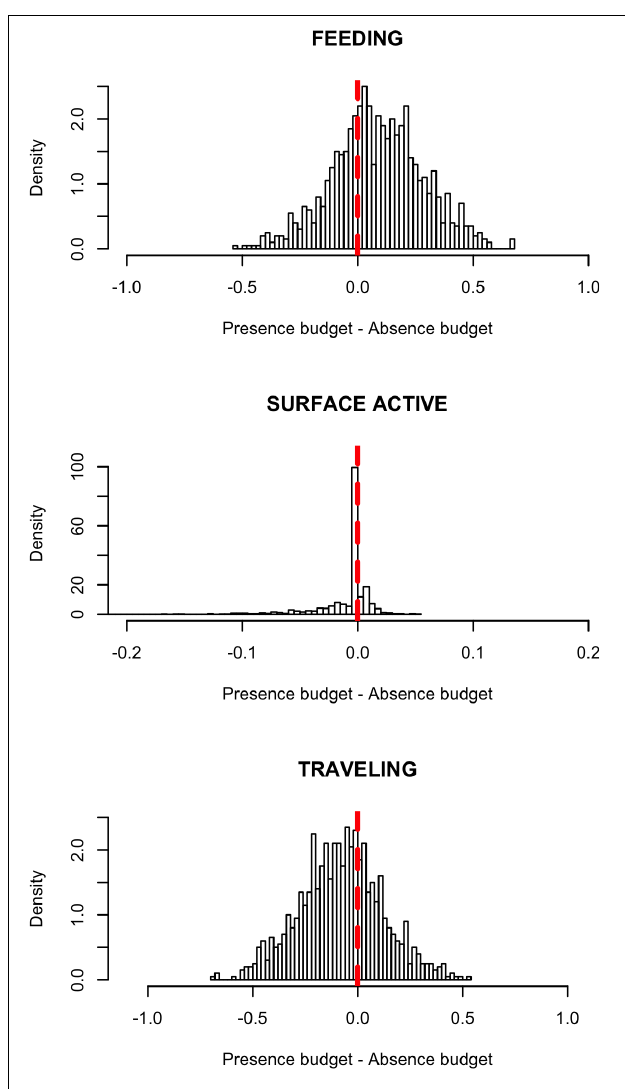
FIGURE 2 | Difference in activity budgets (proportion of time spent in behavioral states) between vessel presence and vessel absence situations. The density distributions derive from 1000 Monte Carlo simulated sightings, each representing a 7.5-h long time series either in the presence or absence of whale-watching vessels. An increase in each state in the presence of vessels is indicated by a positive difference, whereas decrease in each state in the presence of vessels is shown as a negative difference. No difference is represented by red dashed lines.